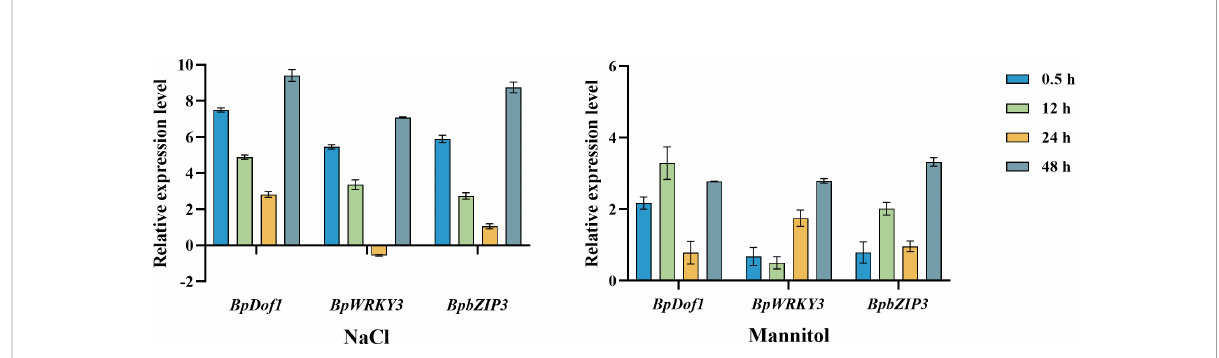
FIGURE 10 Expression patterns of BpDof1 , BpWRKY3 , and BpbZIP3 under different types of abiotic stress. Two-month-old birch seedlings were treated with 200 mM NaCl and 300 mM mannitol for different lengths of time. Plants watered with fresh water were used as control. After these treatments, birch plants were harvested and pooled for RT-PCR analyses. The error bars indicate the standard deviation of three biological